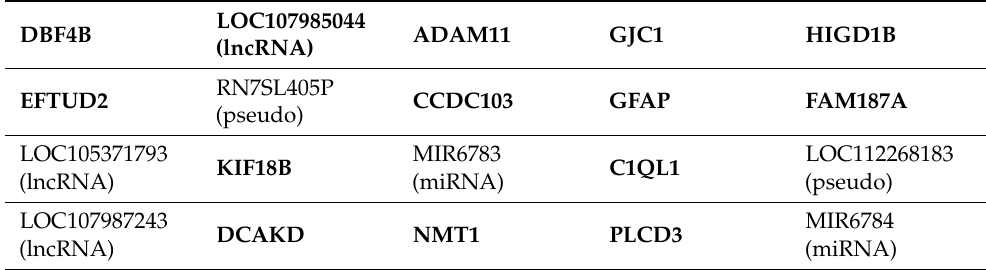
Table A1. A total of 205 genes at the mapped chromosomal locus between the boundaries of markers D17S1861 and